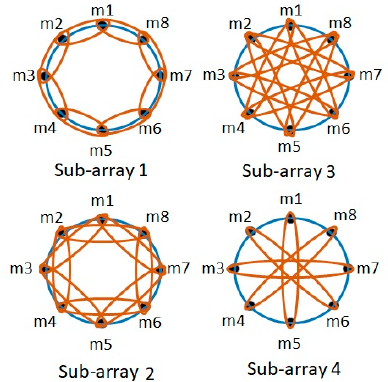
Figure 2. The proposed uniform CNMA and allocated microphones for each subarray.